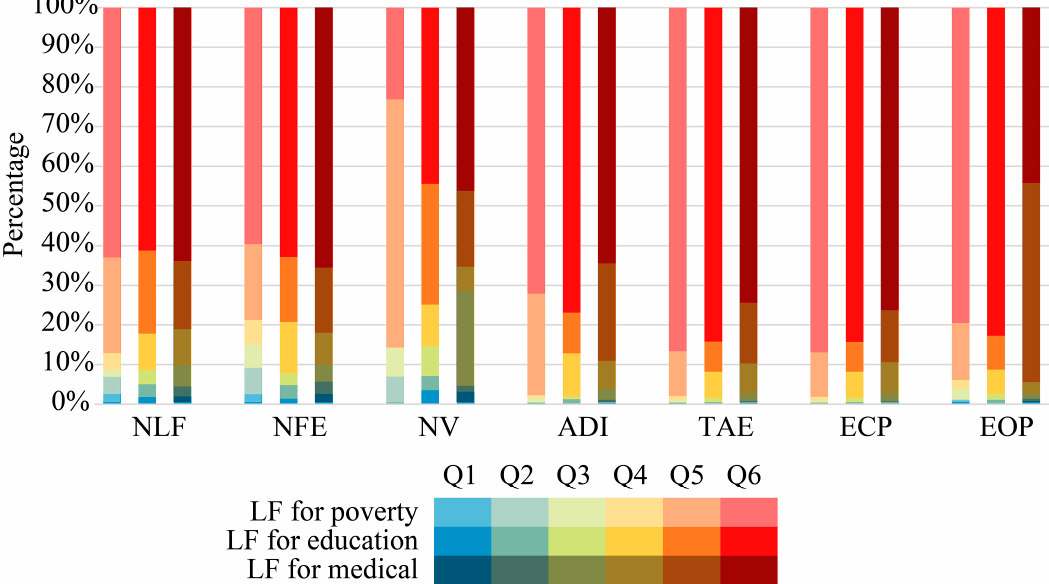
Figure 8. Summaries of local charity foundation attributes within six quantiles of indexes of local population conditions, socio-economic development, education and medical levels indexes.